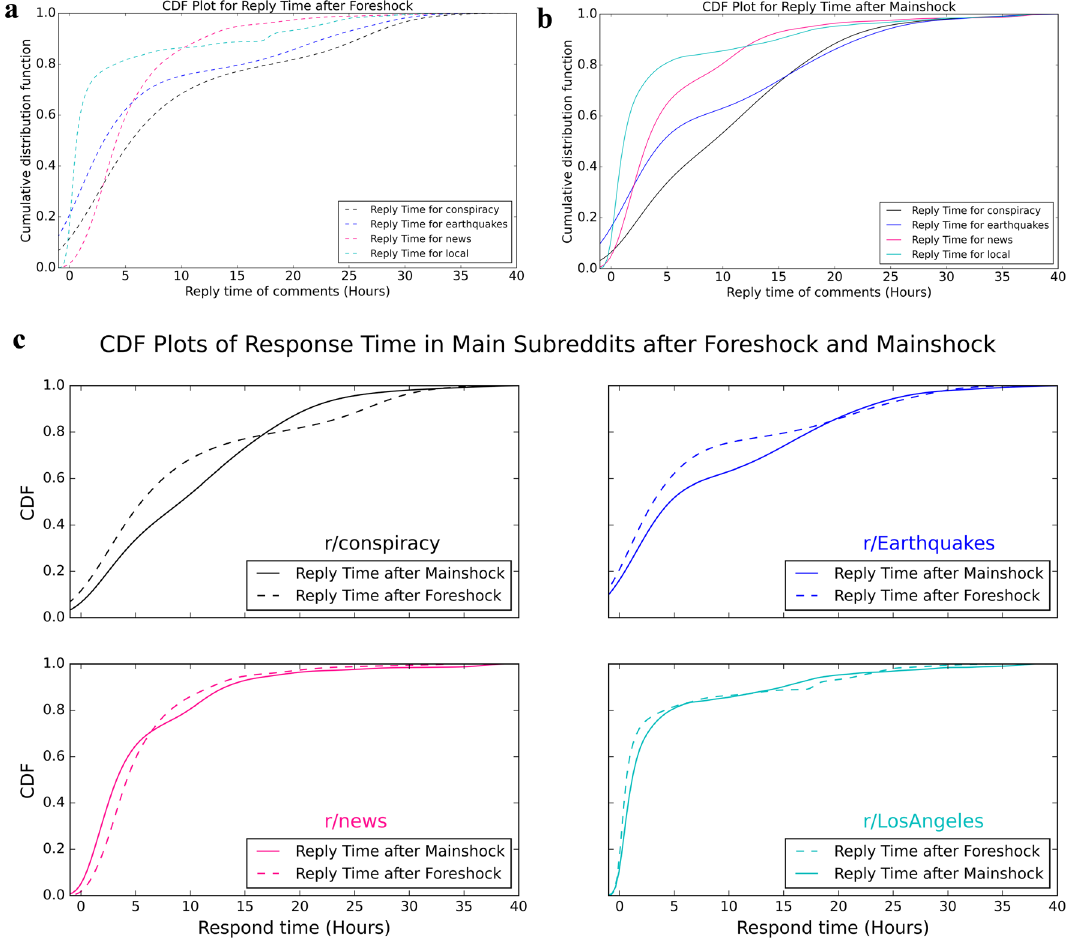
Figure 6. Common URLs’ post time and response time difference on two